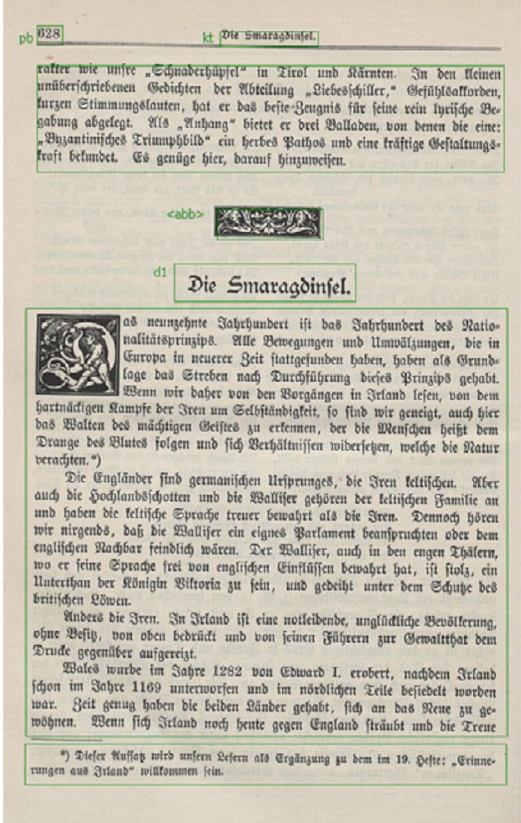
‘Zoning’ — adding structural